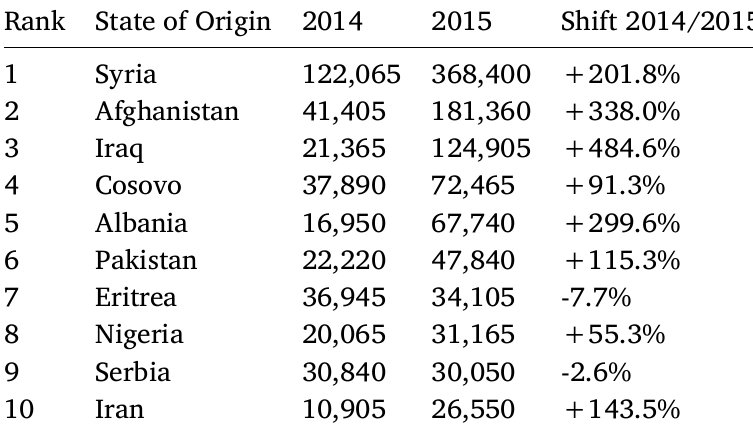
Table 1 Asylum applications from the European Union by country of origin in the years 2014 and 2015 (translated from Bundesamt für Migration und Flüchtlinge 2016,